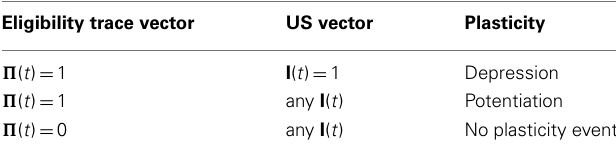
Table 2 | Plasticity conditions